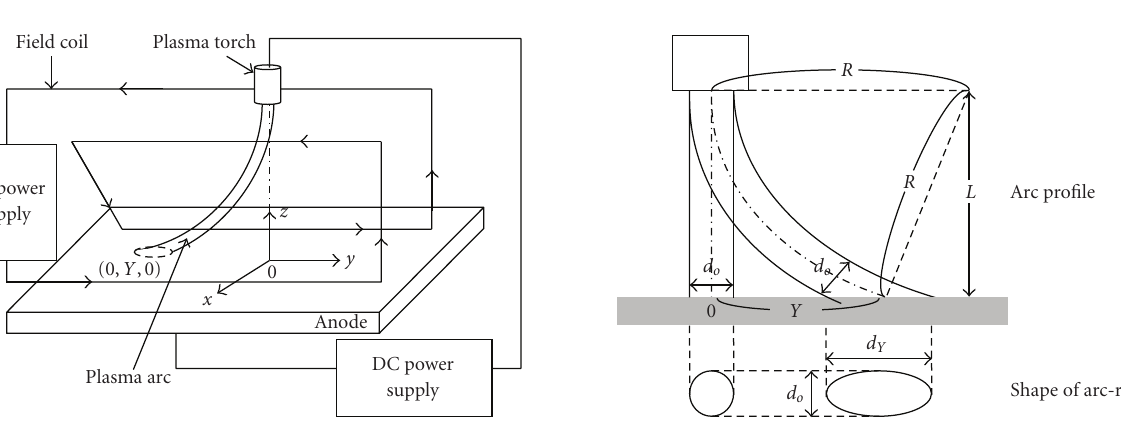
Figure 2: Experimental setup for a magnetically driven arc. Figure 3: Schematic illustration on the arc root